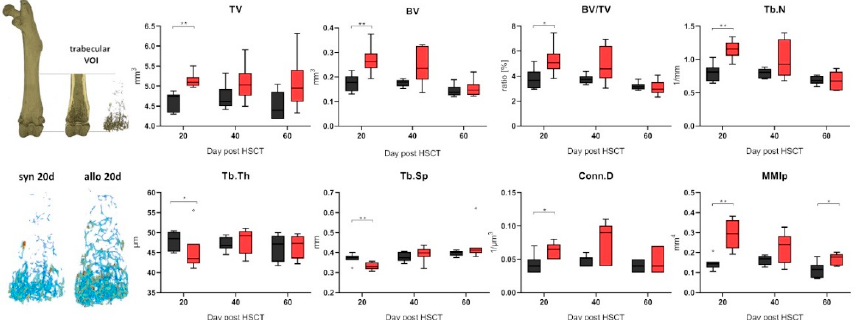
Figure 2. Analyzing the trabecular bone in the distal femora shaft (trabecular VOI is depicted above left) revealed significant differences within the total volume (TV), the bone volume (BV) and the ratio thereof (BV/TV) (syn N = 7, allo N = 6). The trabecular separation (Tb.Sp), number (Tb.N) and connectivity between individual structures (Conn.D) was also significantly altered and the trabecular thickness (Tb.Th) was distinctly lower after allo-HSCT. The polar moment of inertia (MMIp) was significantly increased after allo-HSCT. Shown are representative images. * p ≤ 0.05; ** p ≤ 0.01 by